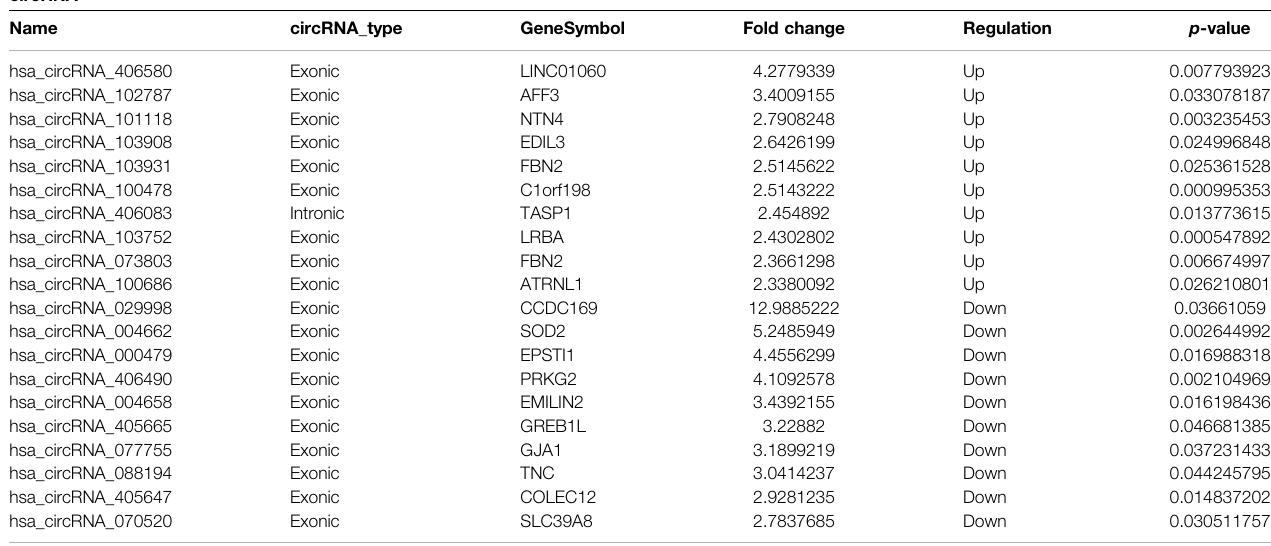
TABLE 1 | Top 20 signi fi cantly dysregulated circRNAs ranked by Fold Changes between KDF and NDF groups. circRNA